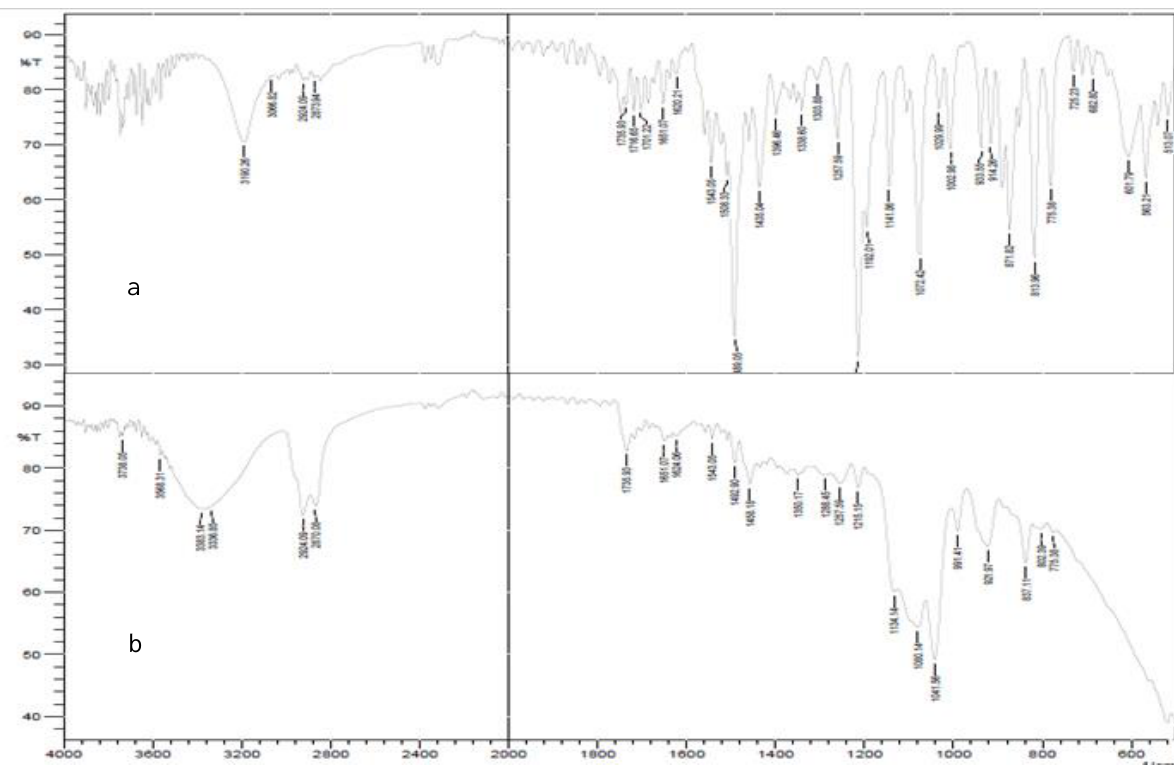
Figure 5.The FTIR spectrum of (a) pure nebivolol powder, and (b) the soluplus-based supersaturable self- nanoemulsion (SAS1) formula